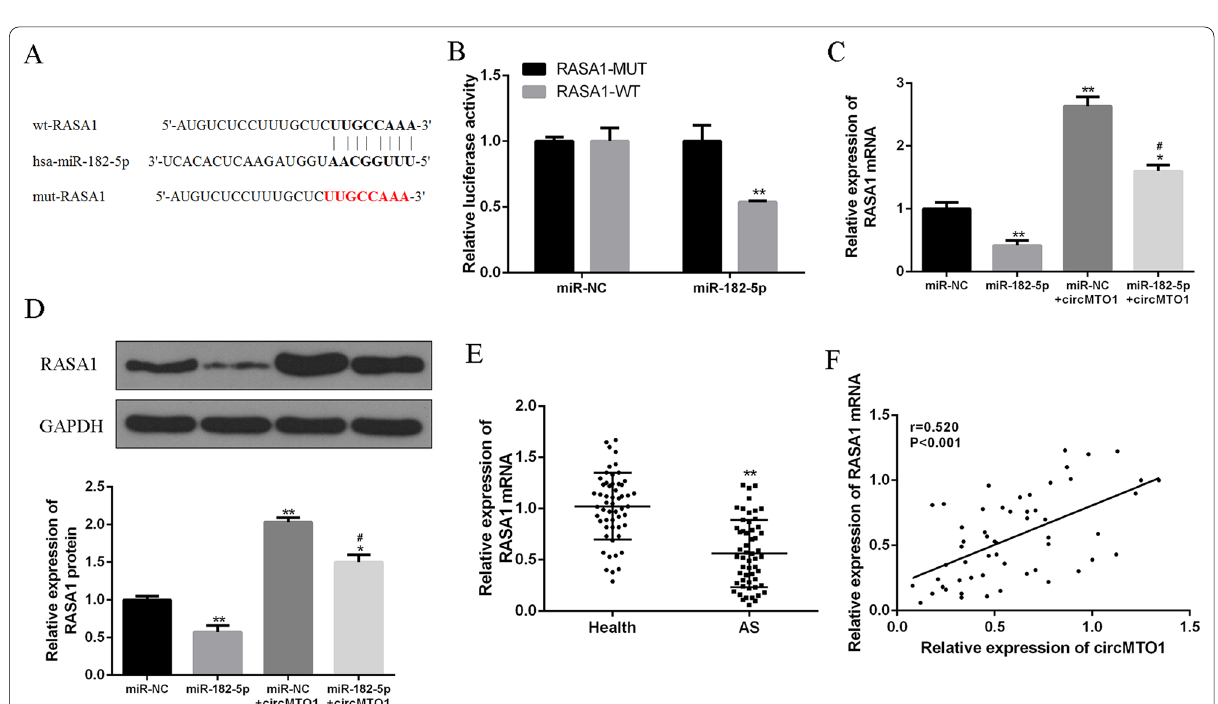
Fig. 4 CircMTO1 upregulated RASA1 expression by sponging miR-182-5p. A Putative binding sites for miR-182-5p and RASA1 3 ′ -UTR. B Luciferase activity in VSMC co-transfected with miR-182-5p mimic and pmirg10-RASA1 3 ′ -UTR-WT or pmirg10-RASA1 3 ′ -UTR-Mut vector. C RASA1 mRNA levels in VSMCs co-transfected with miR-182-5p mimic and circMTO1 vector. D RASA1 protein levels in VSMCs co-transfected with miR-182-5p mimic and circMTO1 vector. E RASA1 mRNA level in serum of AS patients (n 55) and healthy volunteers (n 55). F Pearson correlation analysis of circMTO1 = = and RASA1 in serum of AS patients (n 55). * vs the control group, # vs miR-182-5p mock group. **P < 0.01, ## P < =